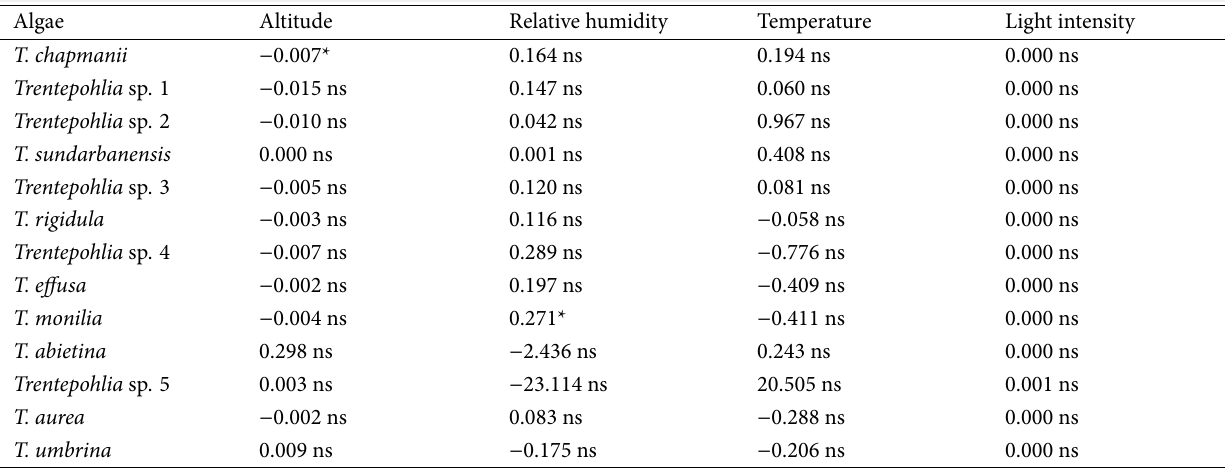
Table 3 Binary logistic regression coefficients of altitude, relative humidity, temperature, and light intensity for the subaerial green algae genus Trentepohlia at 13 sampling points ( p ≤ 0.05, n =